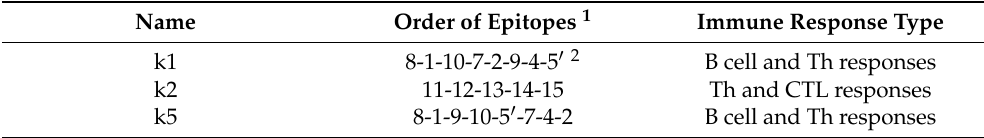
Table 2. The orders of the epitopes in the k1, k2 and k5 constructs. There are no epitopes 3 and 6 from Table 1 in k1 or k5 constructs because epitope 3 is a part of epitope 10, and epitope 6 is a part of 5 (cid:48) (i.e., 5 (cid:48) means the 5-6-5 epitope